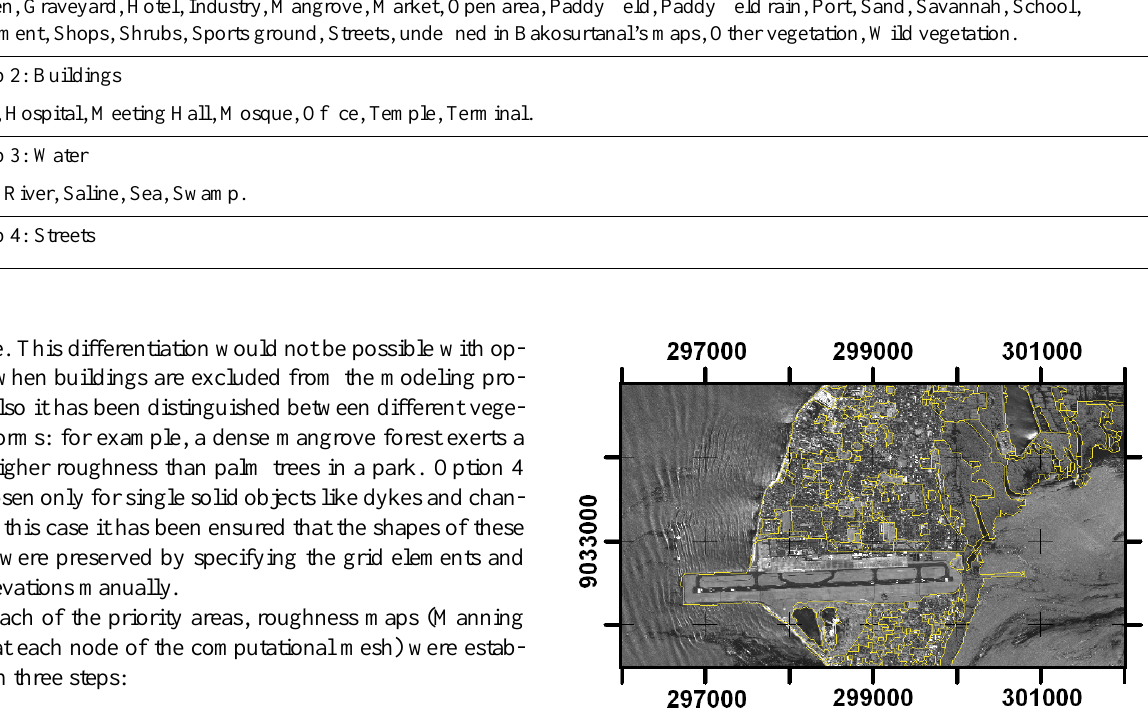
Fig. 1. Quickbird satellite image of airport area of Kuta, Bali. Yel- low lines indicate areas with specific land use classes. Coordinate system WGS 1984 UTM 50